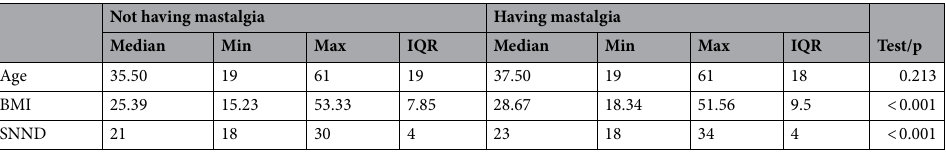
Table 1. Comparison of body mass index measurements of those with and without mastalgia. Mann–Whitney U test was used. Min. minimum, Max. maximum, SD standard deviation, IQR interquartile range, BMI body mass index, SNND distance from the sternal notch to the nipple.